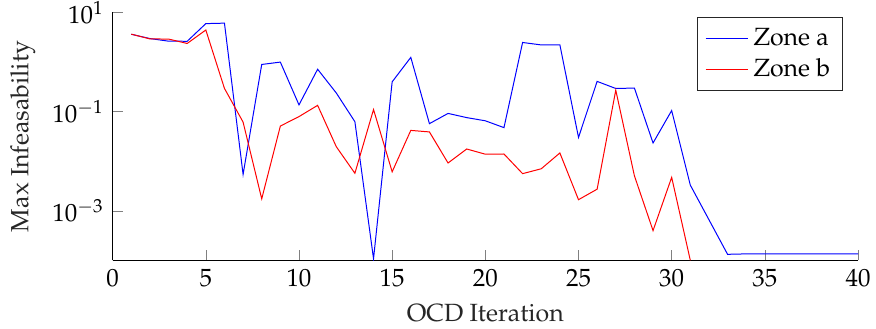
Figure 3. Maximum infeasibility per zone when solving the four-node network using flat